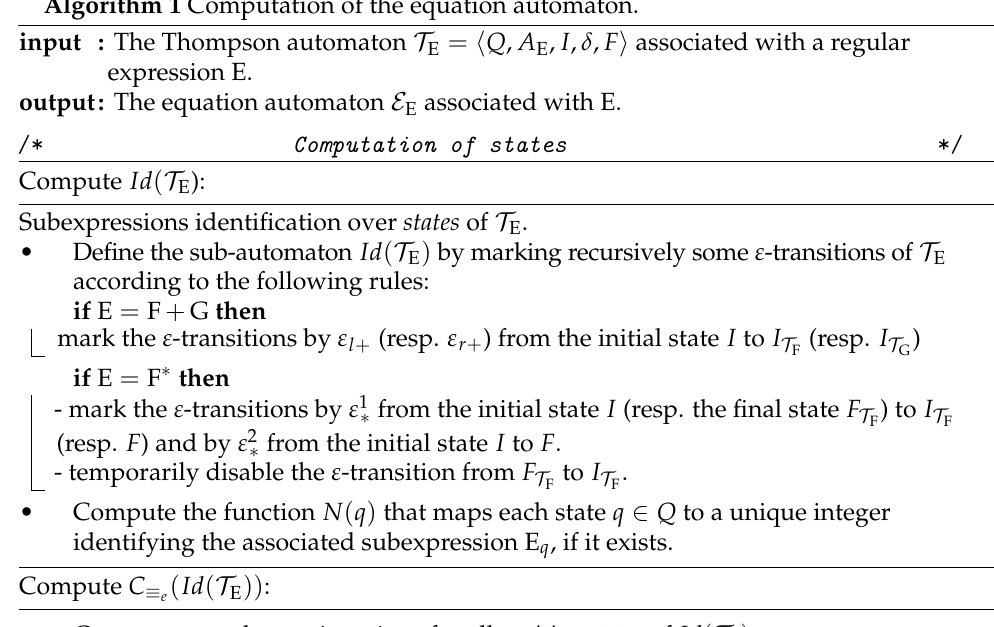
Algorithm 1 Computation of the equation